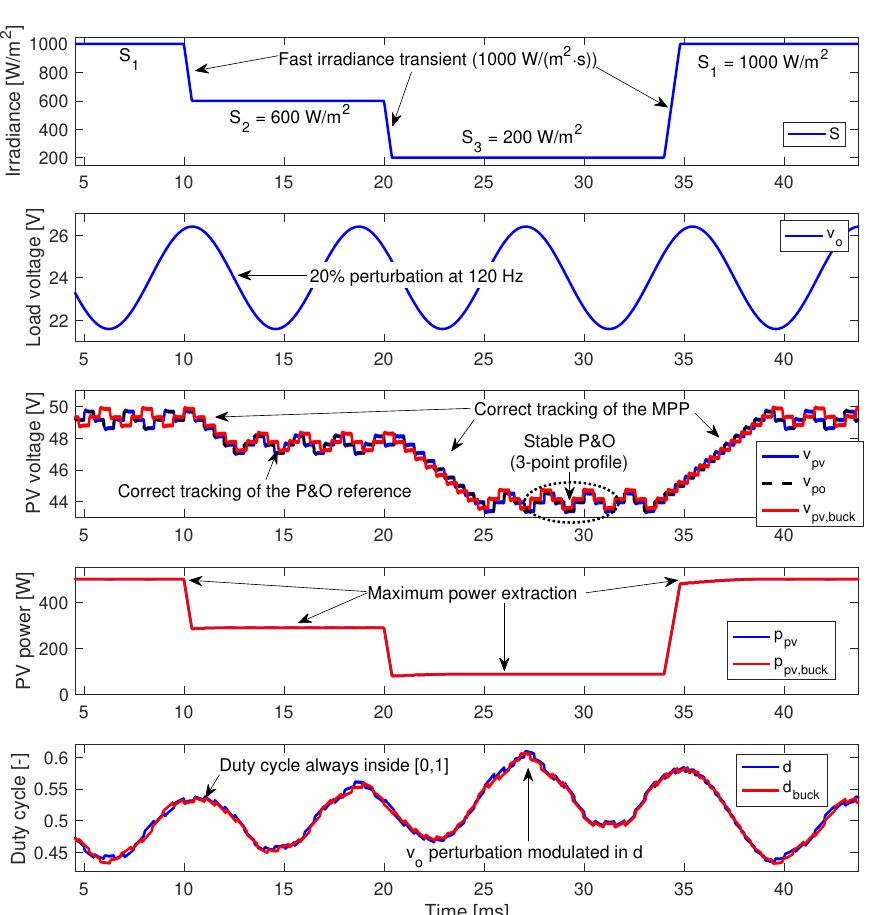
Figure 17. Maximum power point tracking using the CIOC converter with SMC and the classical buck converter with